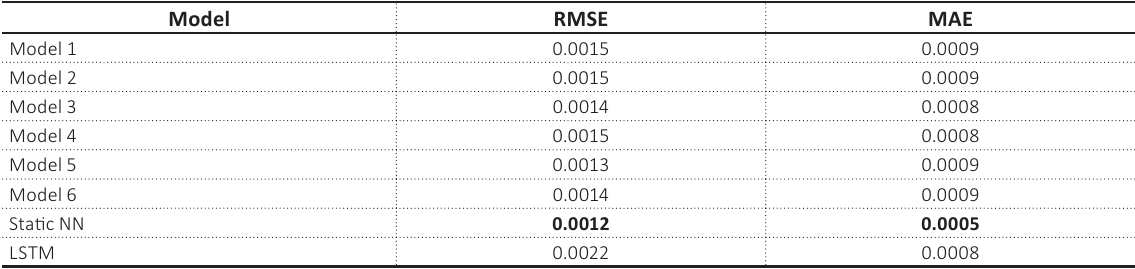
Table 5. Out-of-sample results (RMSE and MAE estimates)